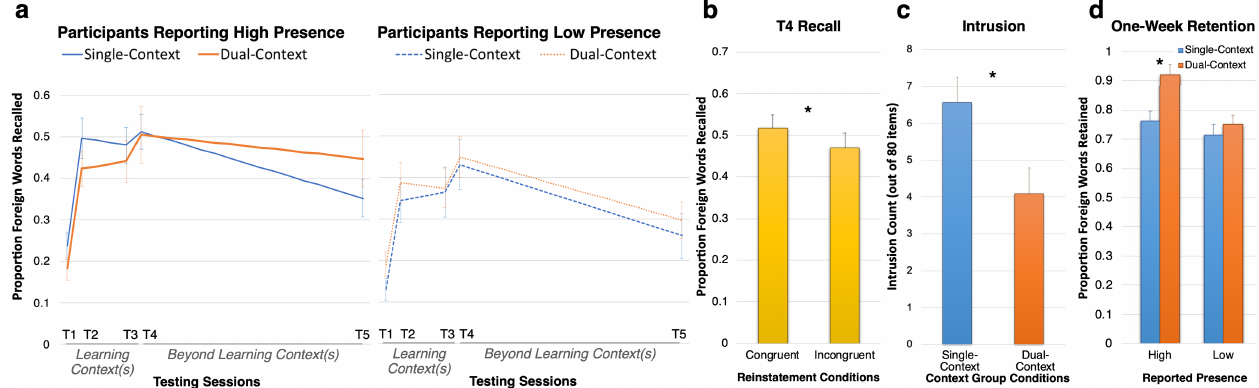
Fig. 3 Behavioural experiment results. a overall recall performance, split by context group and presence. b Main effect of mental reinstatement on T4 recall. c Main effect of context group condition on intrusions. d Interactions of context group and presence in one-week retention. * denotes statistical signi fi cance, error bars denote standard error of the